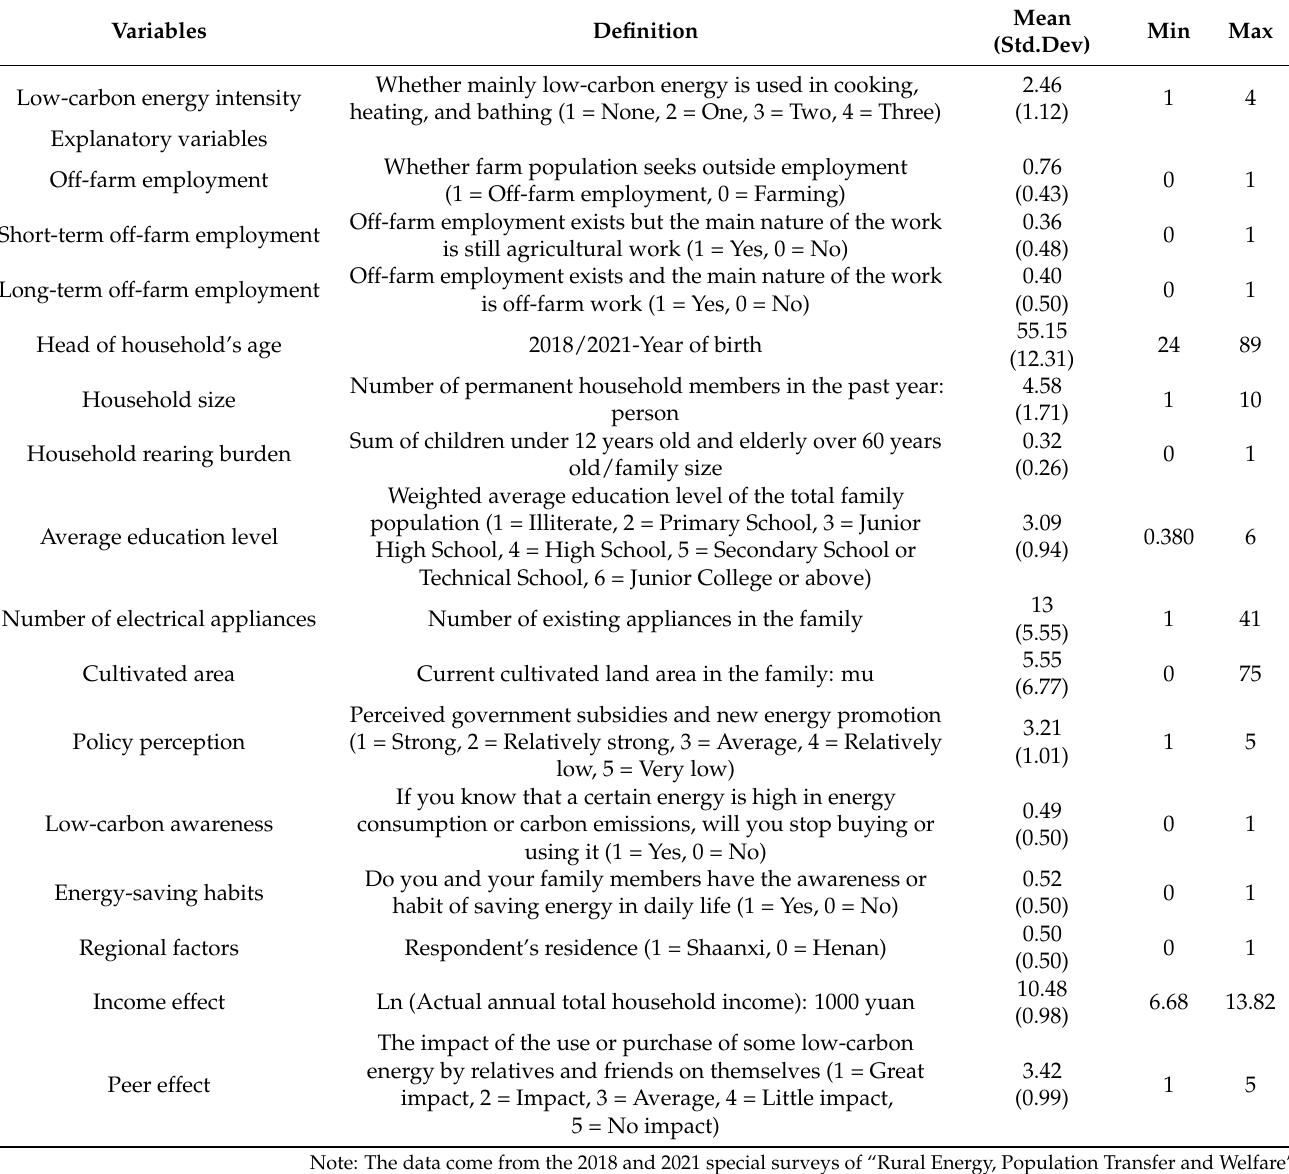
Table 1. Variable Meaning, Assignment, and Statistical